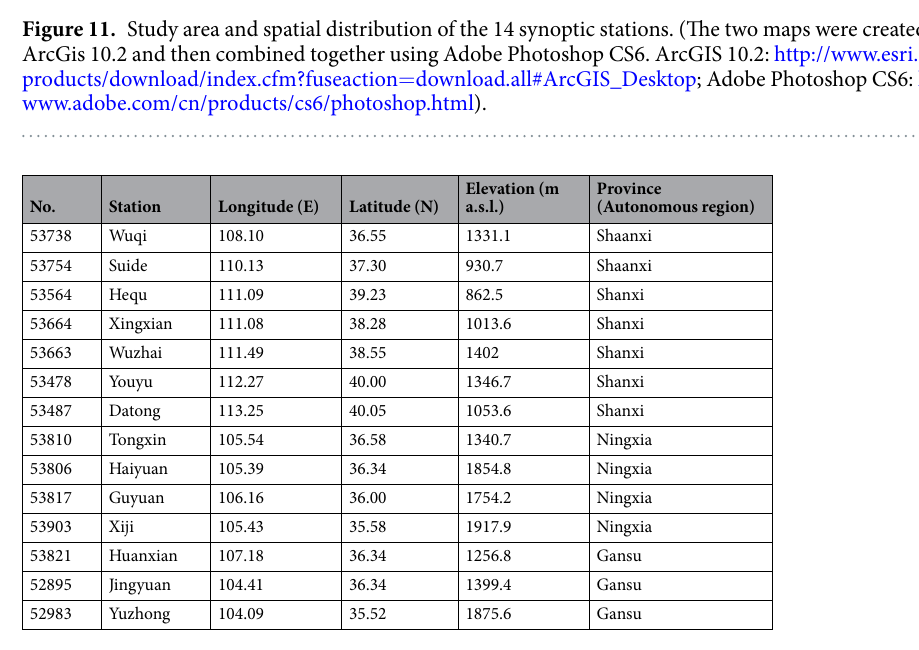
Table 6. Geographical descriptions of the synoptic stations used in this